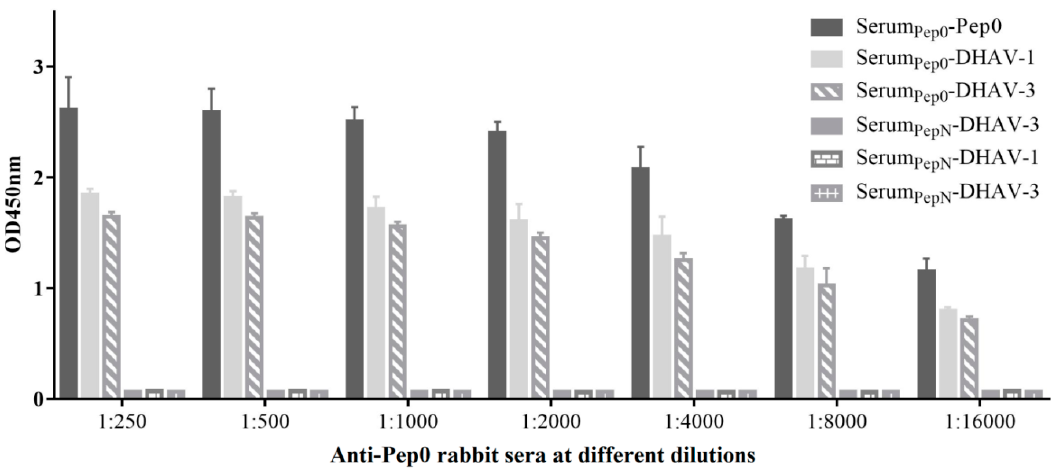
Figure 5. Antibodies bound to the peptide Pep0, DHAV-1, and DHAV-3 in the immunized rabbit sera. The sera were collected from the rabbits at 7 days after the third immunization with Pep0-KLH and tested by ELISA. Values represent three independent experiments with triplicates for each experiment.